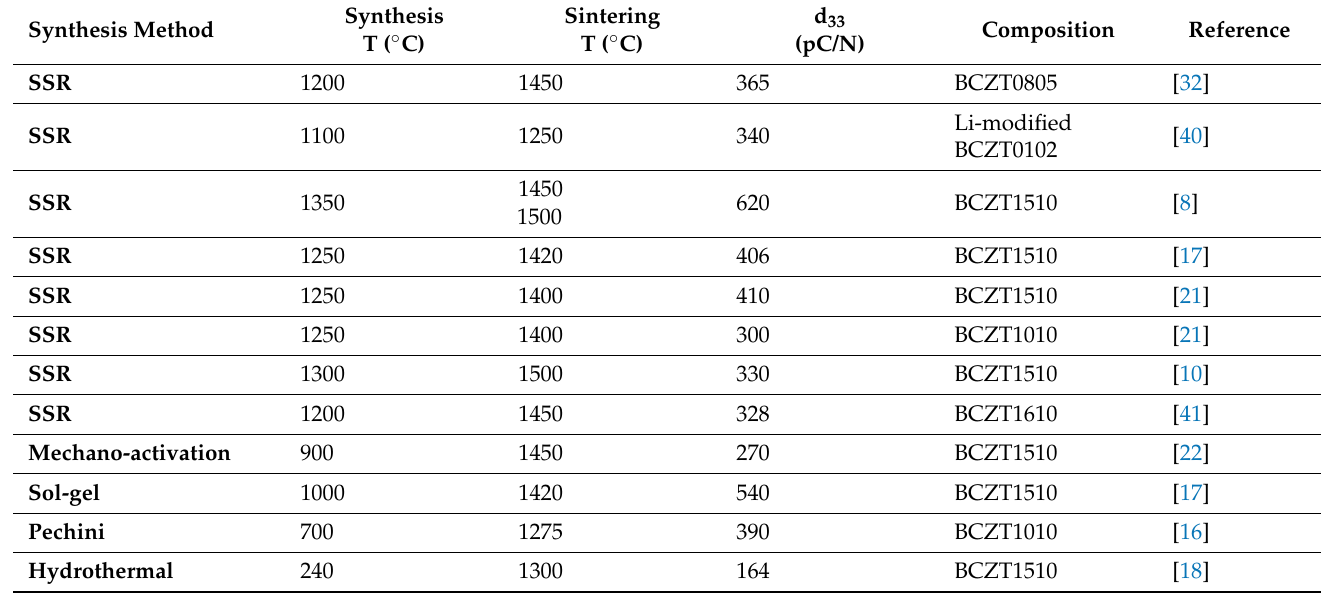
Table 5. Comparison of the piezoelectric coefficient (d33) of different BCZT compositions prepared by different synthesis routes. SSR = solid-state